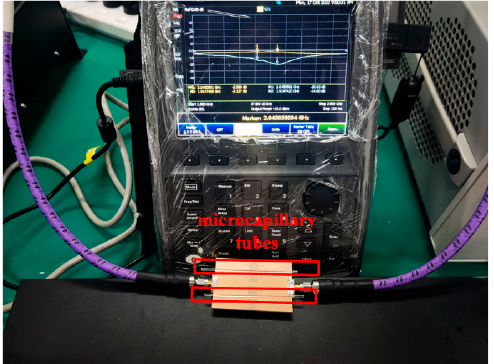
Figure 5. The measurement setup: optimized sensor surrounded by two microcapillary tubes and connected to the Keysight N9916A VNA. Two resonances in the S 21 magnitude are visible on the instrument’s display.